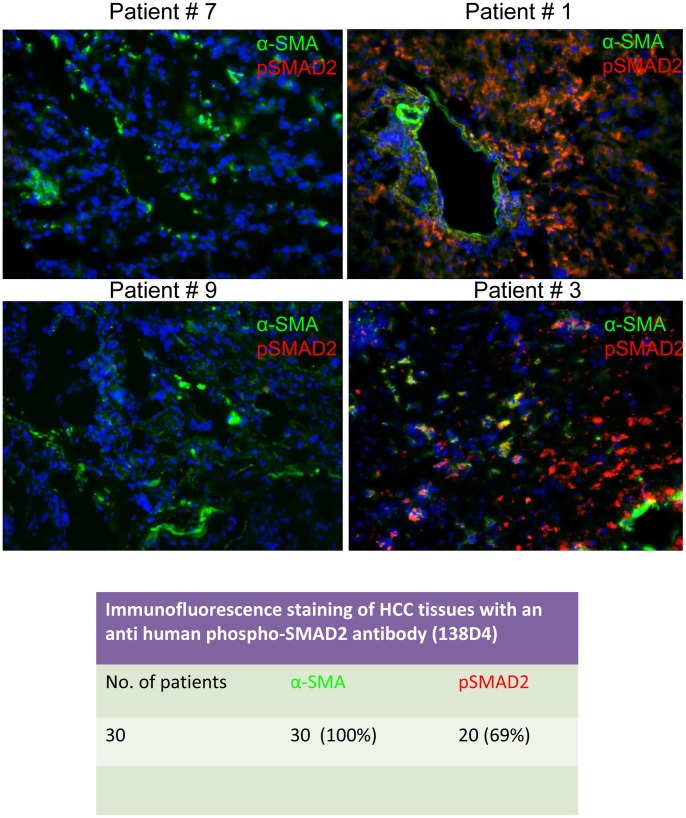
Immunofluorescence staining of p-Smad2 in frozen HCC tissues.Tissues from 30 patients with HCC were stained using an anti-p-Smad2 polyclonal antibody (red) and alpha smooth muscle actin with the monoclonal antibody clone 1A4 (green). In 20 out of 30 HCC tissues (69.0%) positivity for p-Smad2 was obtained; representative cases of p-Smad2-positive (patient #1 and #3) or -negative (patients #7 and #9) tissues are shown.